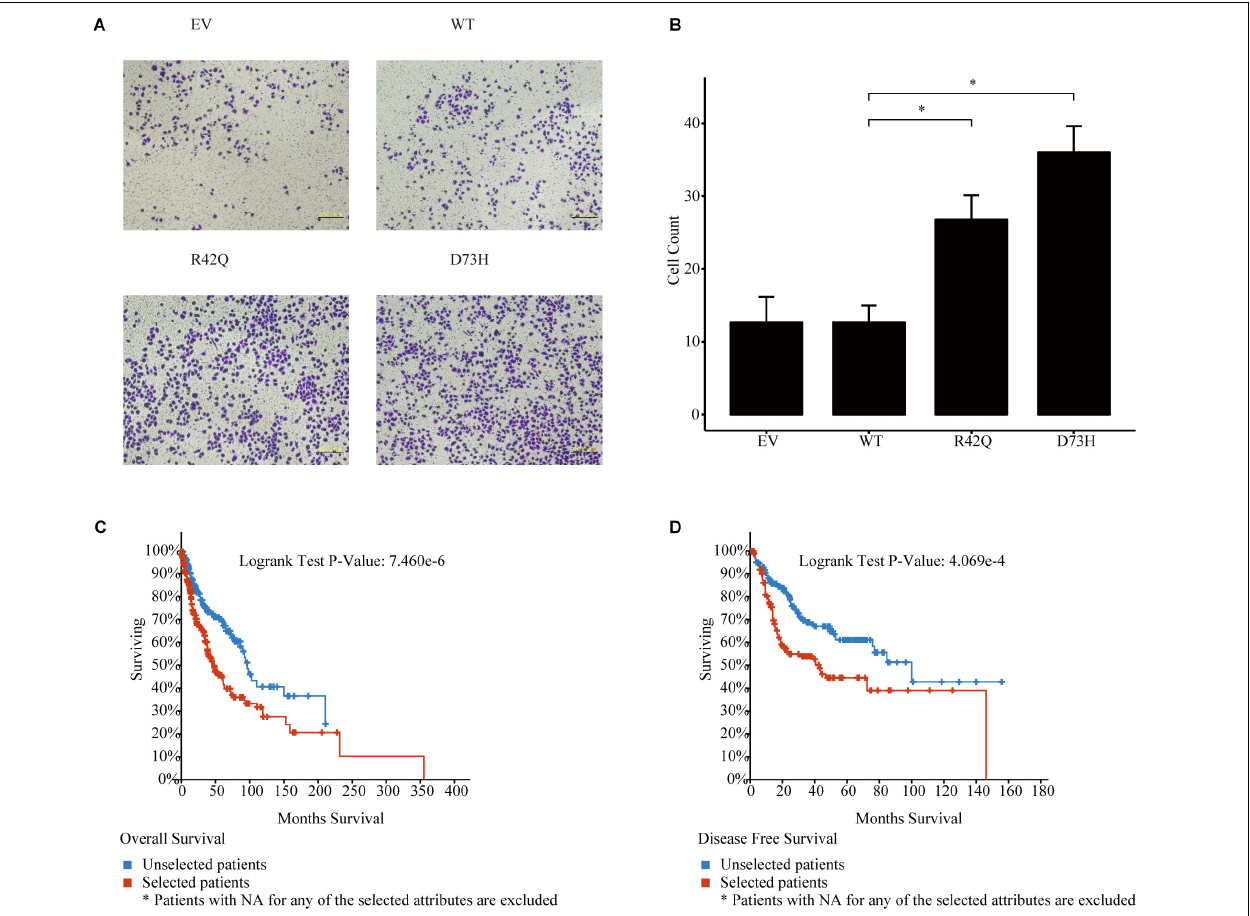
FIGURE 3 | Roles of NCK1 in tumor progression might be context dependent. (A) Images of MCF7 cells migrated from transwell membrane (B) Cell count and quantitative analysis of the migrated MCF7 cells. Patients with both NCK1 aberrations and TP53 mutations showed a much poorer overall survival (C) and disease-free survival (D) . Selected patients: patients with both NCK1 aberrations and TP53 mutation. Unselected patients: patients with only NCK1 aberrations. Scale bar: 200 µ m. Data are depicted as mean ± standard deviation